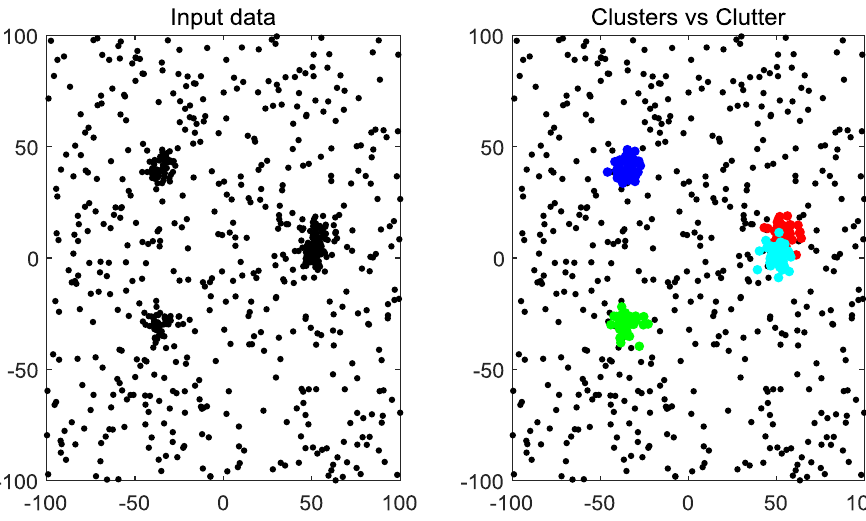
Figure 1. Multi-sensor i.i.d data points.